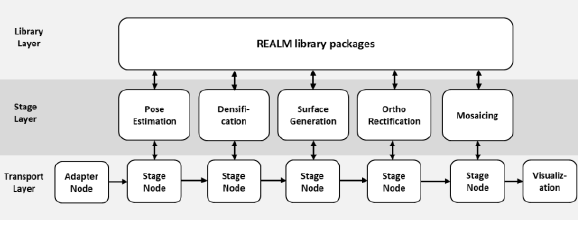
Figure 8: The architecture of the OpenREALM